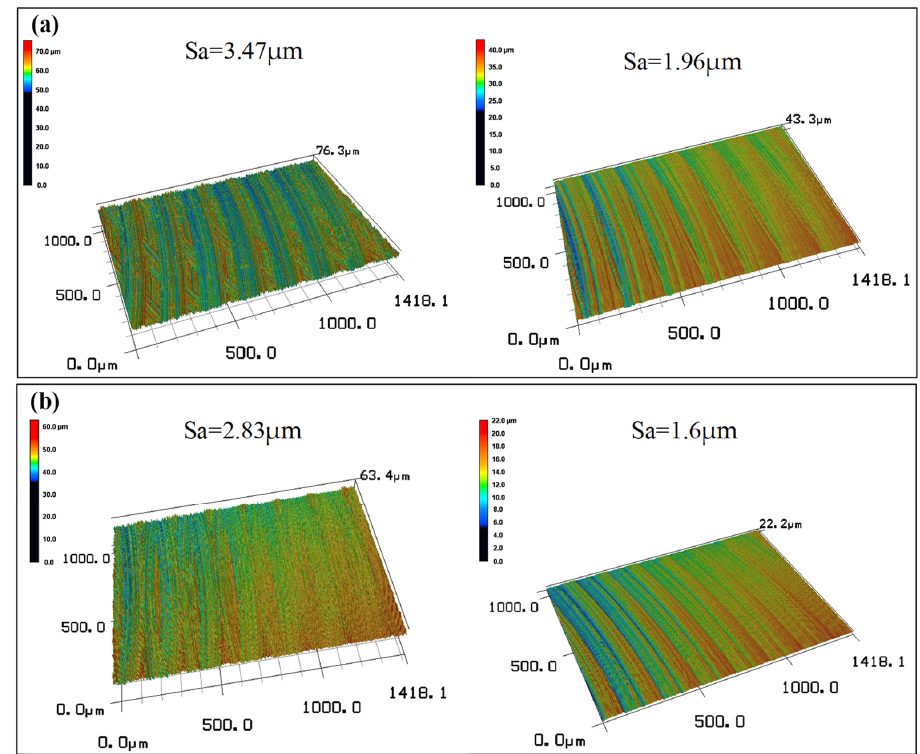
Figure 7. 3D surface morphology at the beginning and end of machining time under two cutting fluid conditions: ( a ) CCF-10 ( b ) QC-2803.